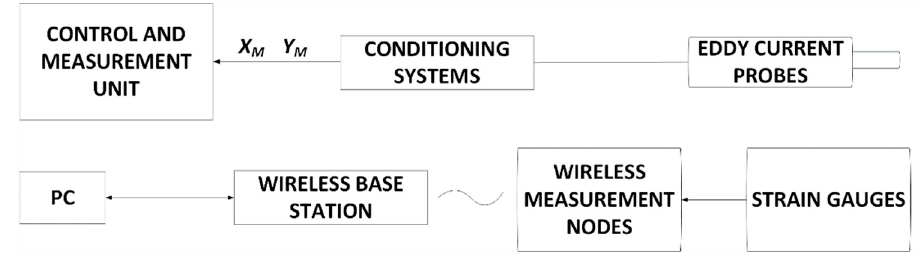
Figure 7. Flowchart with the overall measurement process.